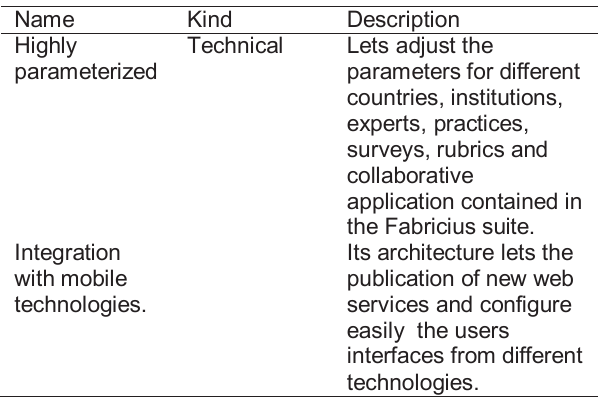
Table 9. Main Fabricius